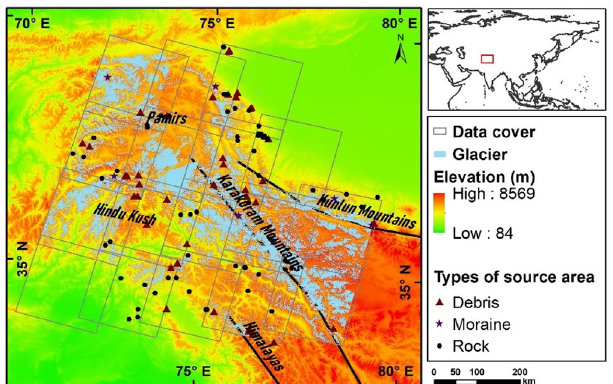
Figure 4. Study area. The gray rectangles represent the coverage of the Landsat images. Triangles, pentagons, and circles represent three types of landslide source area. The blue filled areas are glacier-covered areas (Figures created using Arcgis10.2 https ://www.esri.com/en-us/arcgi s/produ cts/arcgi s-deskt op).